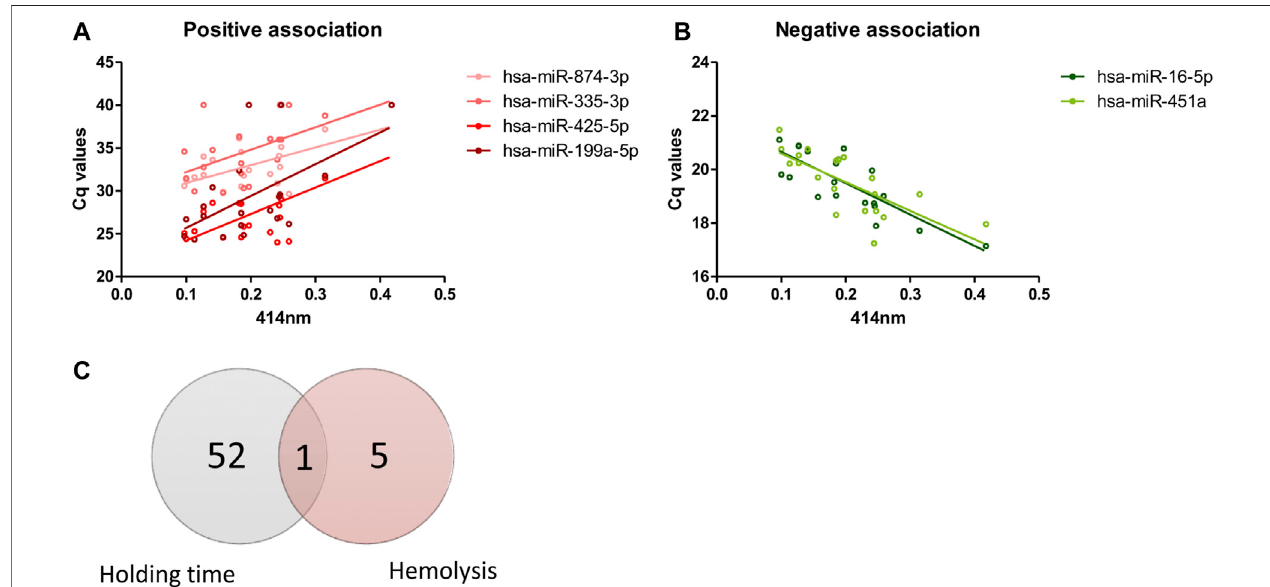
FIGURE 4 | Effects of hemolysis on plasma miRNA expression pro fi les . Risk of hemolysis was found to be higher with increasing blood holding time. Correlation between plasma miRNAs and hemolysis was assessed. The Cq values of four miRNAs demonstrated positive correlation with hemolysis (A) and Cq values of two miRNAsdemonstratednegativecorrelationwithhemolysis (B) .VenndiagramshowingthenumberofmiRNAswhoseexpressionisaffectedbywholebloodholdingtime prior to plasma processing and/or level of hemolysis (C) .